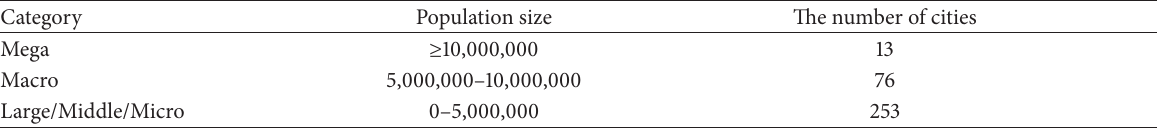
Table 1: Urban hierarchy by population in China.